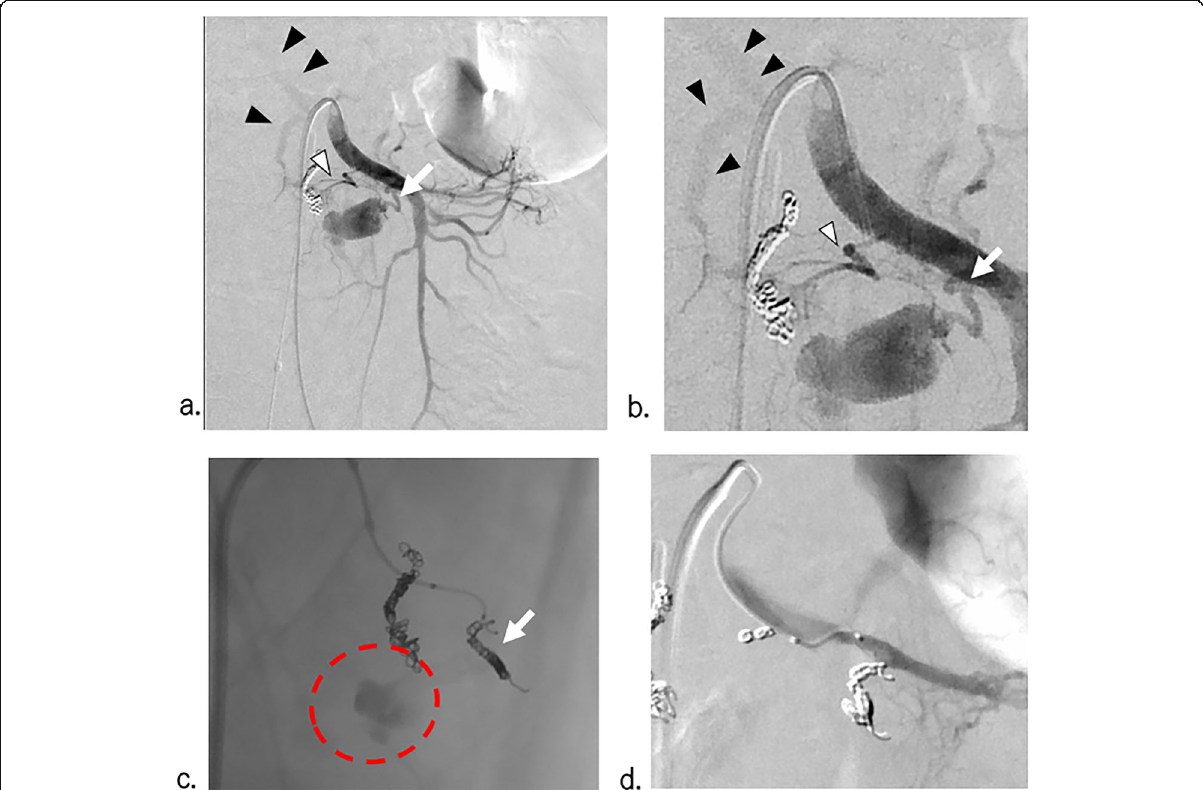
Fig. 3 SMA angiography at emergency transarterial embolization ( a ) ( b ) SMA angiogram showing a rupture of the AIPDA (white arrow) and early visualization of the portal vein (black arrowheads). The PIPDA (white arrows) was suspected to be involved in the haemorrhage. c Digital angiogram, obtained after coil embolization of the proximal AIPDA (white arrow), showing continued extravasation (red circle) from the AIPDA. d AIPDA angiogram after 50% NBCA lipiodol injection to the AIPDA, showing the disappearance of extravasation, with maintained normal blood flow in the branch of the SMA near the AIPDA. ※ AIPDA: anterior inferior pancreaticoduodenal artery ※ PIPDA: posterior inferior pancreaticoduodenal artery. ※ NBCA: n-butyl-2 cyanoacrylate. ※ SMA: superior mesenteric